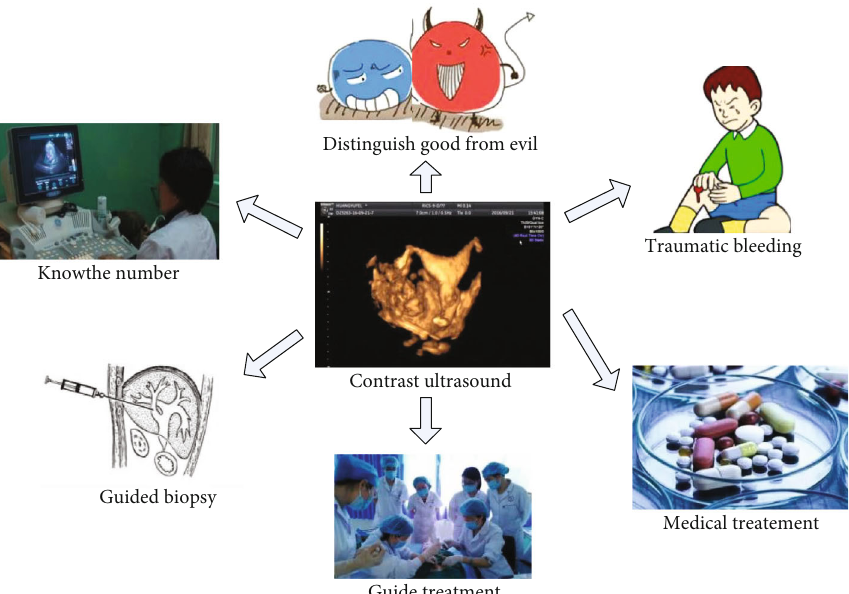
Figure 2: Advantages and applications of contrast-enhanced